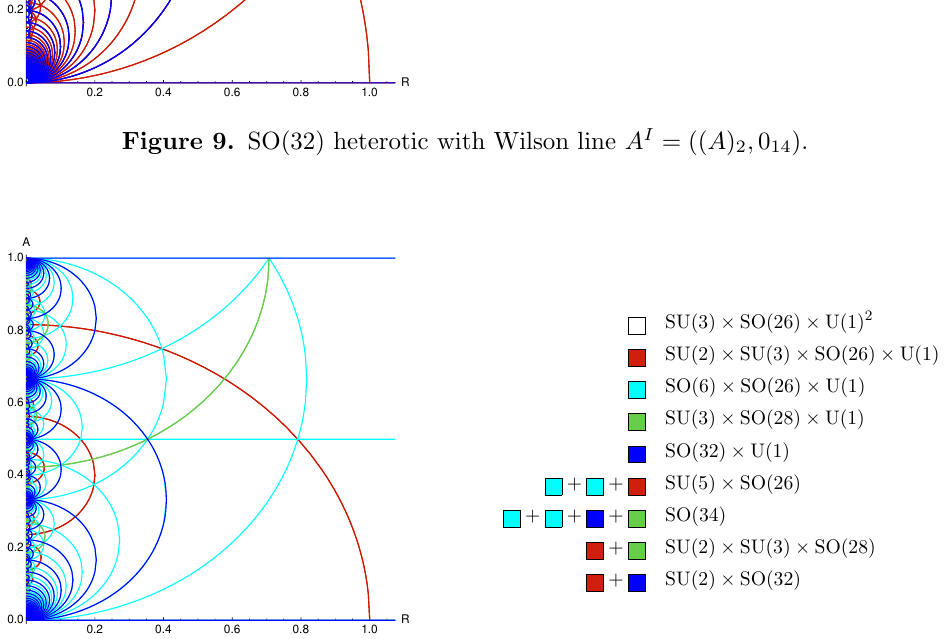
Figure 10. SO(32) heterotic with Wilson line A I = (( A ) 3 ; 0 13 ).